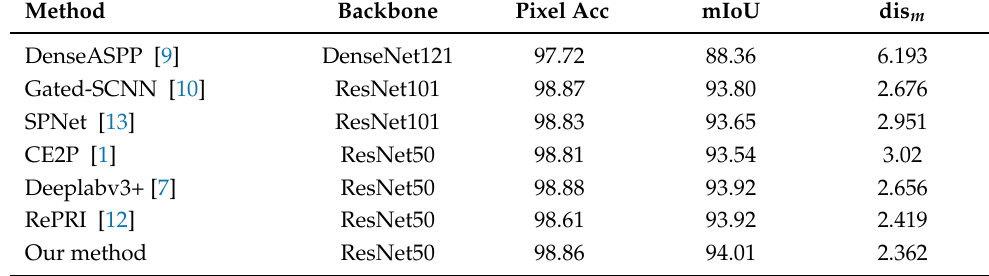
Table 3. Result comparison between state-of-the-art segmentation methods and our method. “Pixel acc” is pixel accuracy, “mIoU” represents mean intersection over union, “dis m ” denotes the mean shortest distance between the locations of pixels of the predicted under-the-clothes profile and the locations of pixels of the labeled profile.